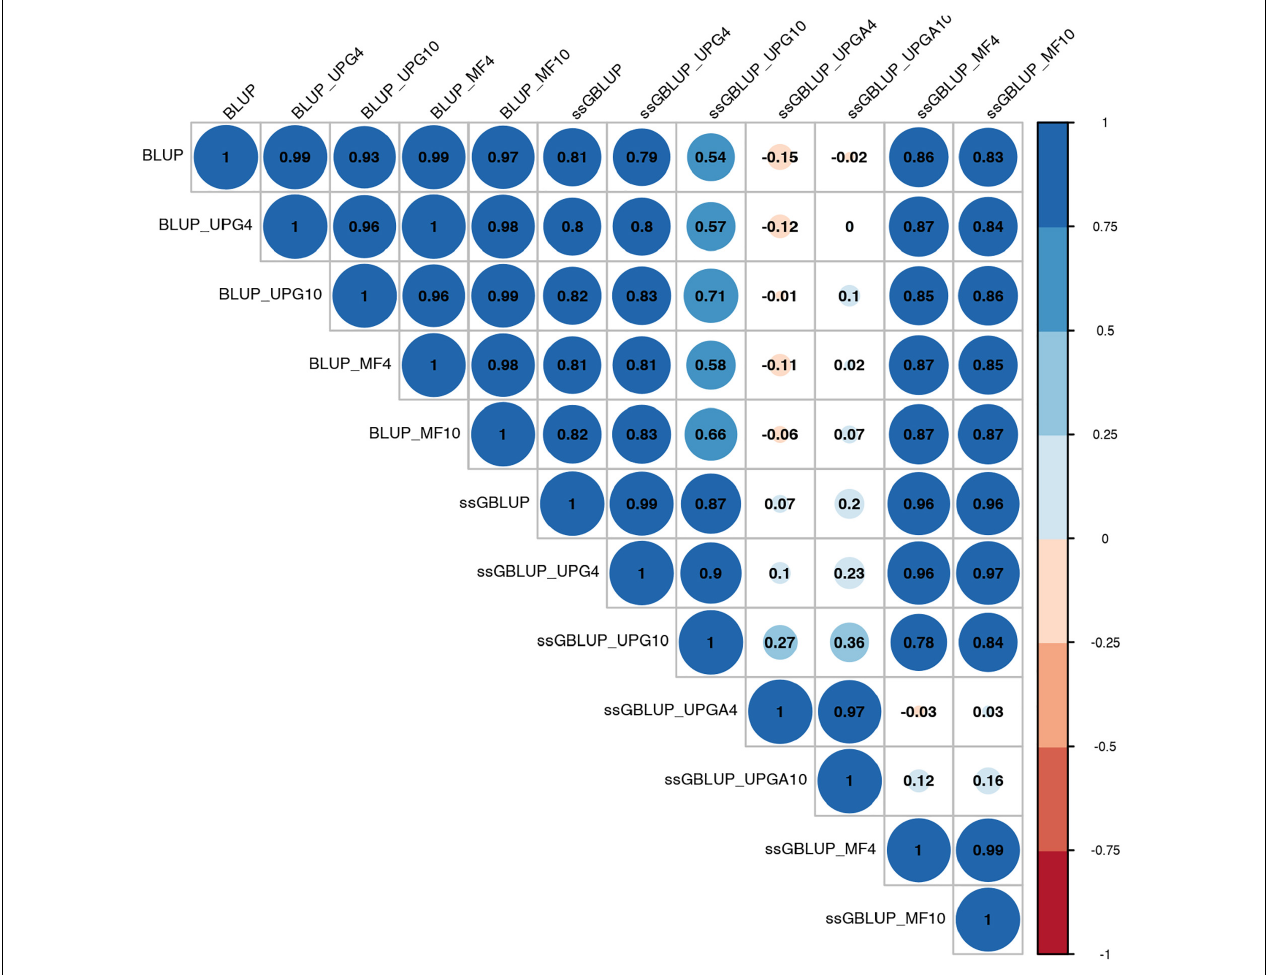
FIGURE 2 | Correlations between breeding values for post weaning weight gain estimated using various models with and without genetic